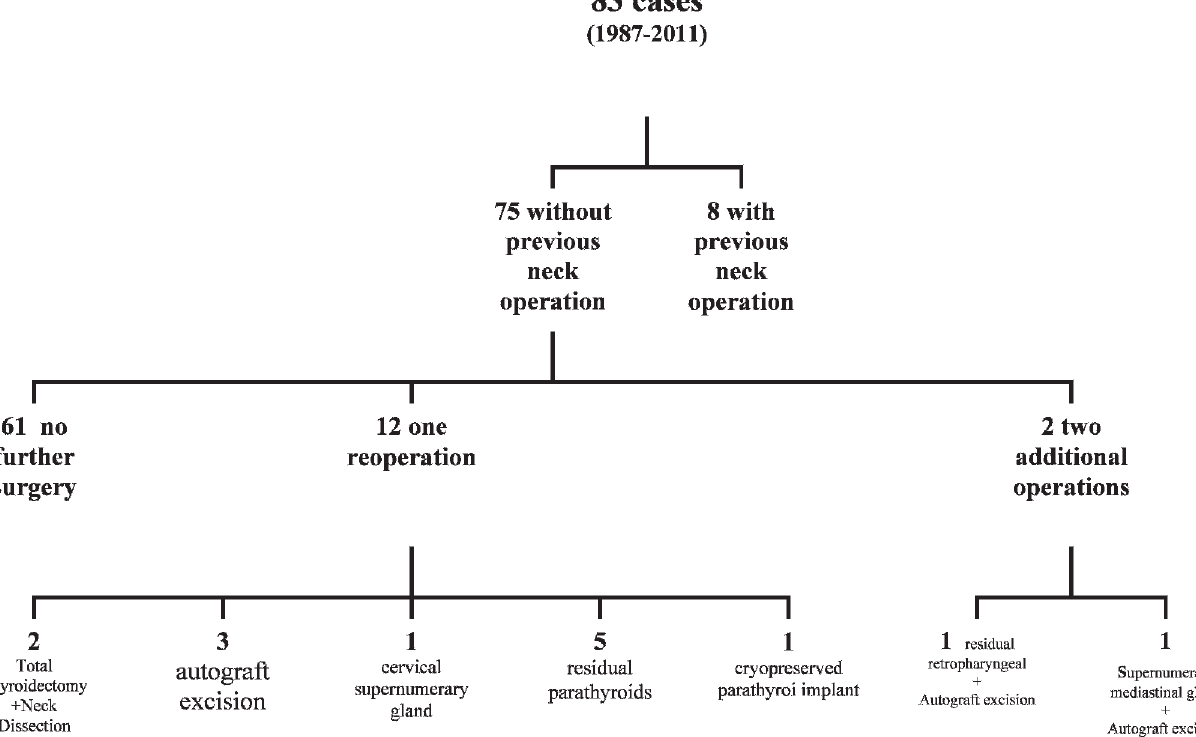
Figure 3 - Distribution of patients with hyperparathyroidism/multiple endocrine neoplasia type 1 who had not had a previous neck operation (1987 to